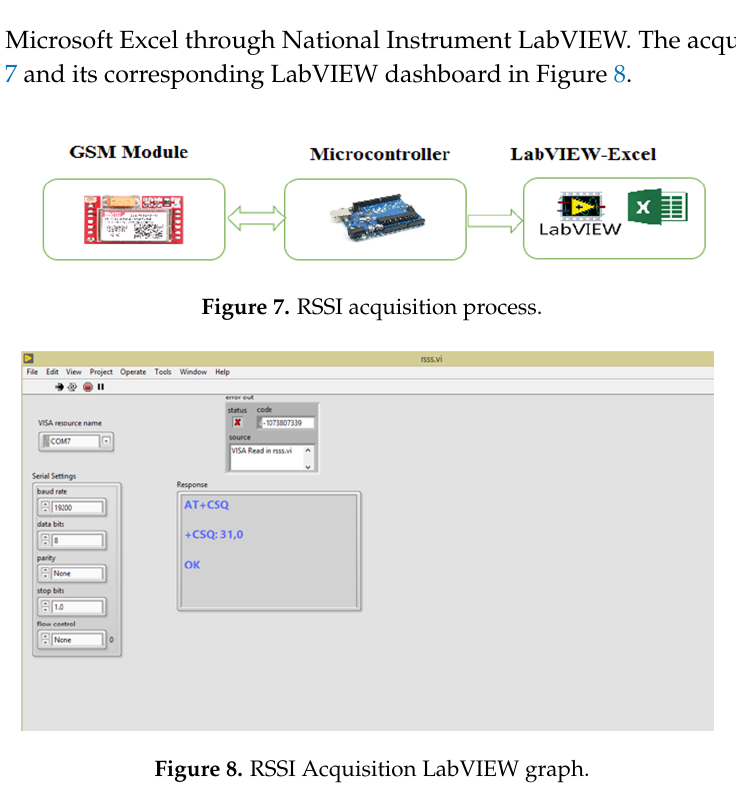
Figure 8. RSSI Acquisition LabVIEW graph.